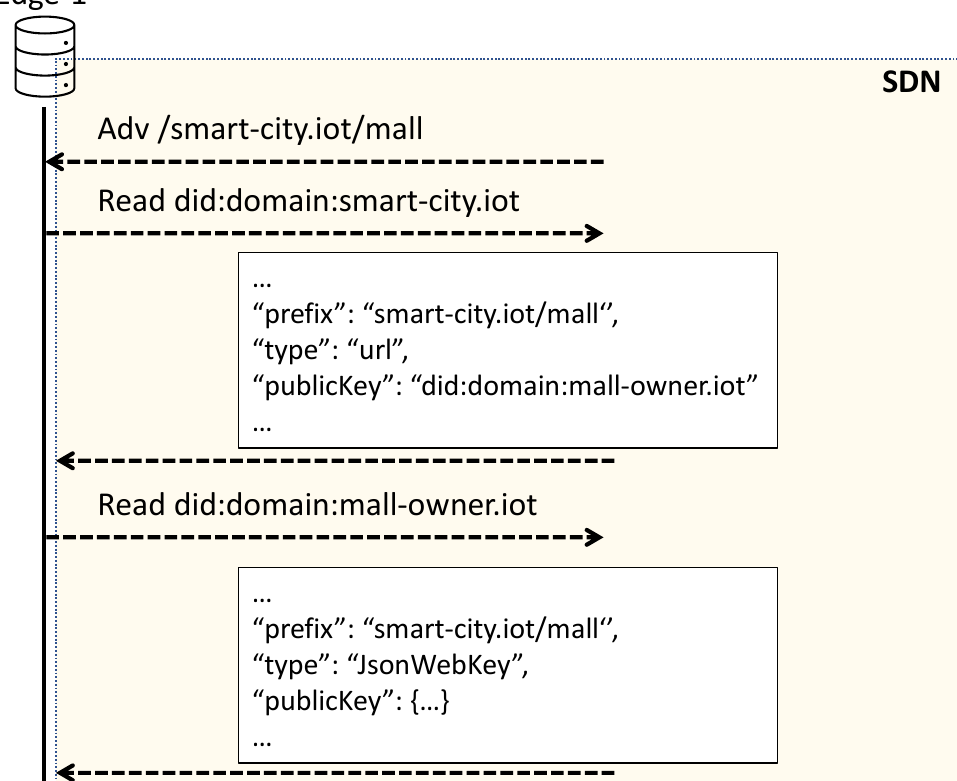
Figure 2. Assertion key